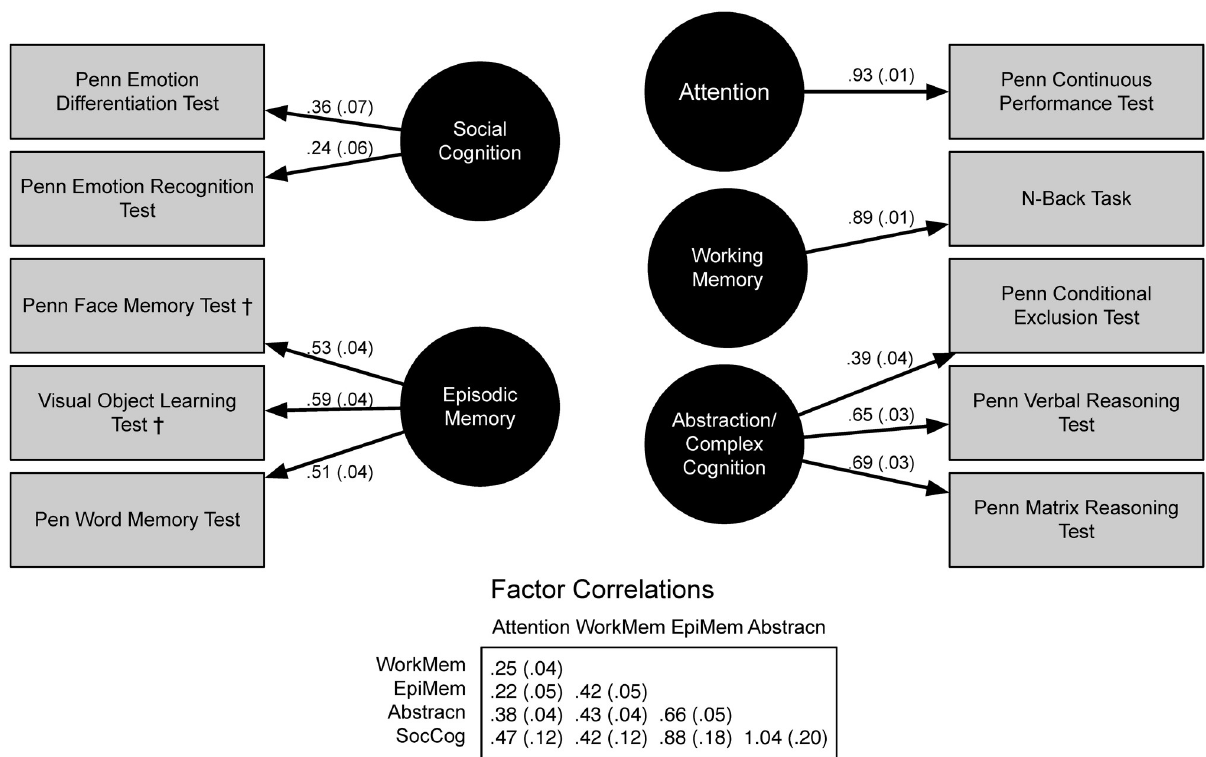
Fig 2. Confirmatory factor analysis estimates of the 8-Factor model for the Penn CNB suite of tests.